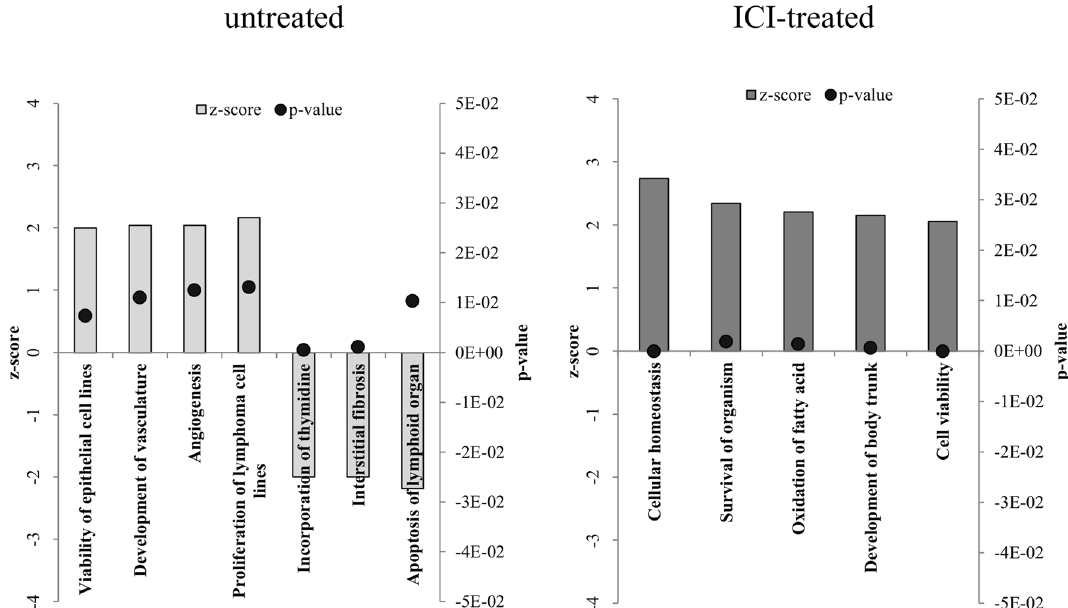
Figure 3. Diseases and functions identified in the heart by the Ingenuity Pathway Analysis based on the comparison of stressed with non-stressed untreated rats (4 rats/group), and those stressed and unstressed treated with ICI118,551 (4 rats/group). Bars indicate z-score, and black dots indicate the p value for each category. The thresholds were a z score of ≥ 2 or ≤ − 2 and p value of ≤ 0.05. A list with additional information is available in Supplementary Table S3.